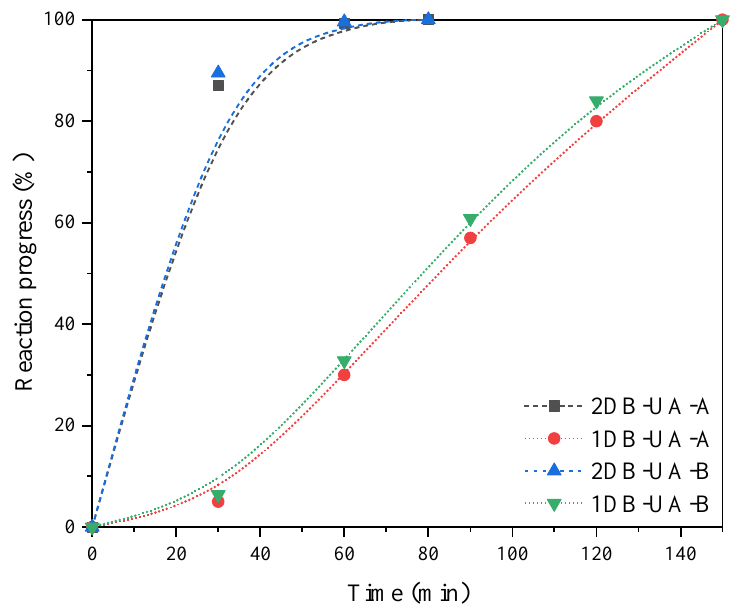
Figure 4. Monitoring of disappearance of NCO peak with the progression of the addition of PDO to the isocyanate-bearing urethane acrylates considering the use of stoichiometric molar ratio of substances (A) and the ratio with excess of PDO (B).